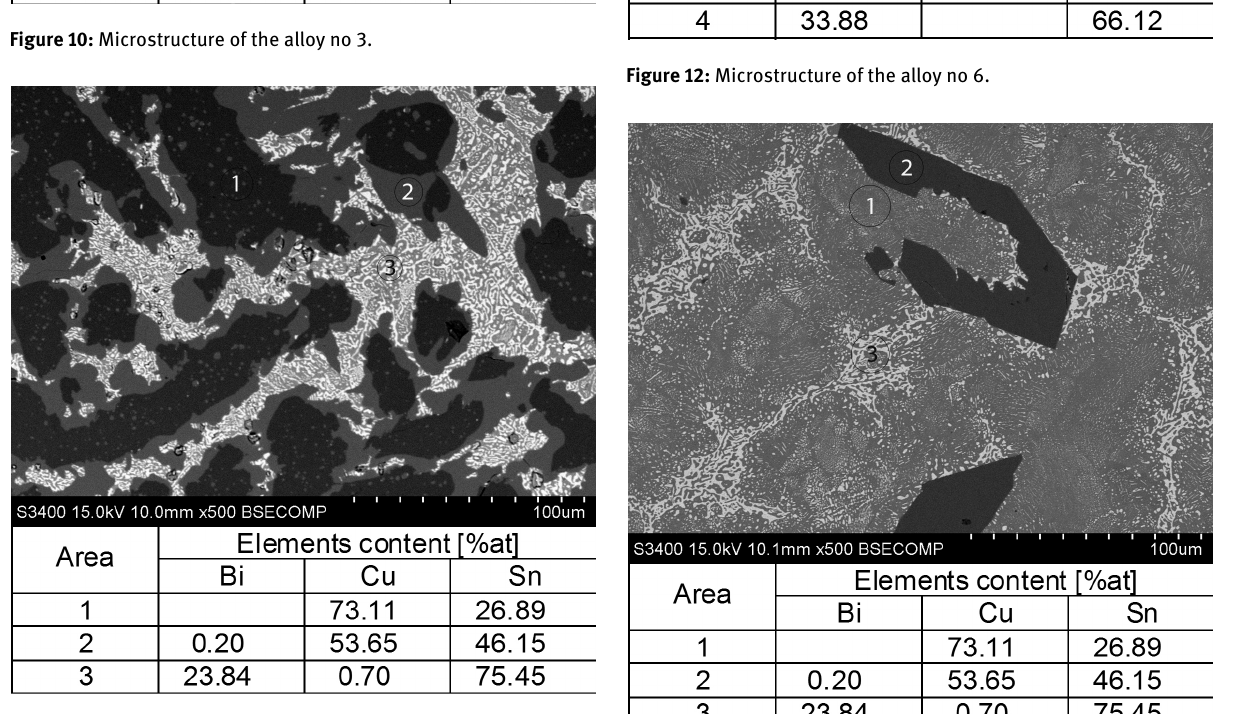
x =0.045) the reported liquidus temperature (902 ∘ C) Sn